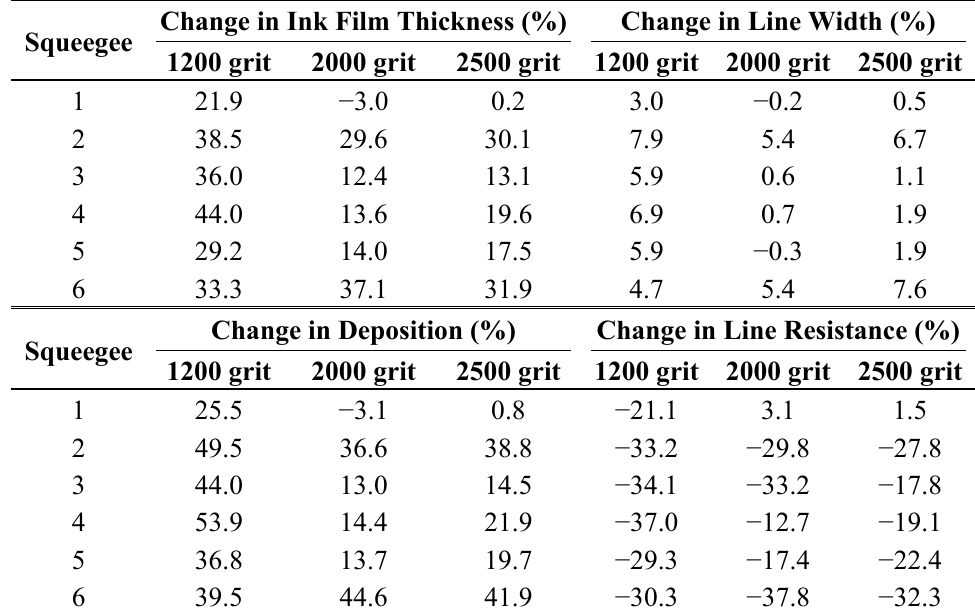
Table 7. Percentage change in printed ink film thickness, line width, ink deposition and line resistance as a result of squeegee wear. Data as average for all measured lines.